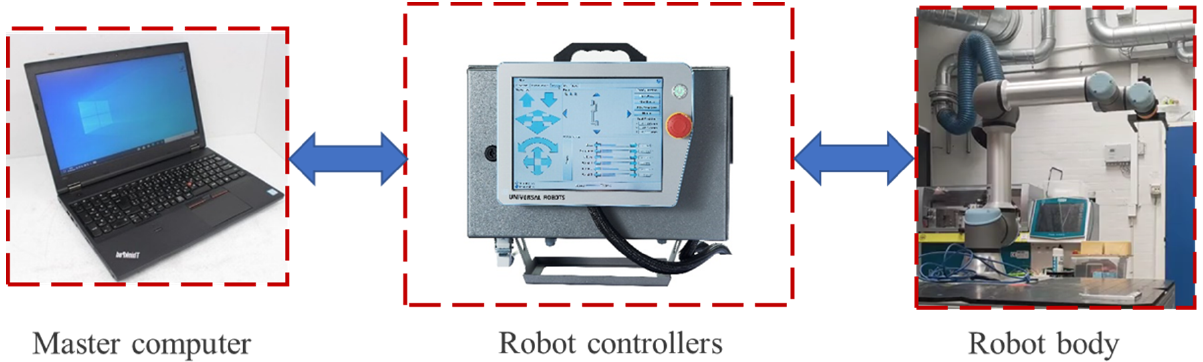
Figure 11. UR5E robotic arm test platform.